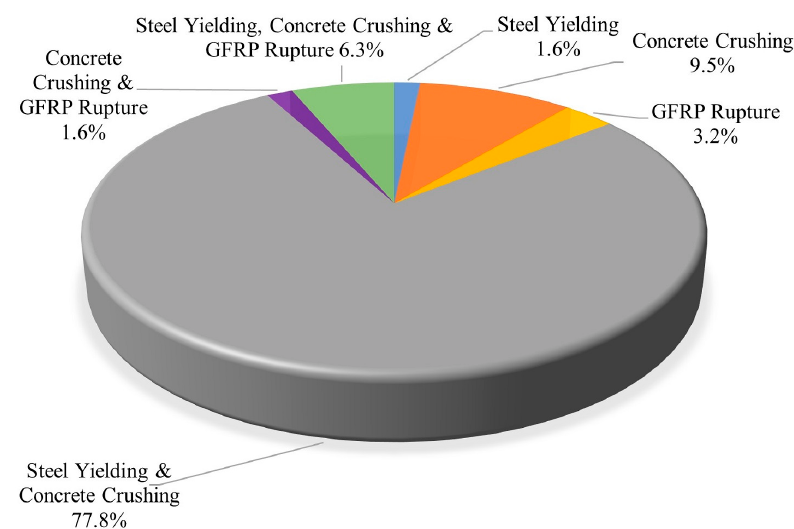
Figure 7. Distribution of failure modes in hybrid GFRP–steel beams reported in Table 2.